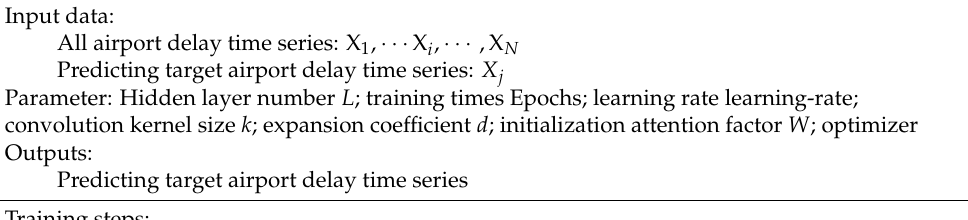
Table 1. Training steps of the deep time-domain prediction